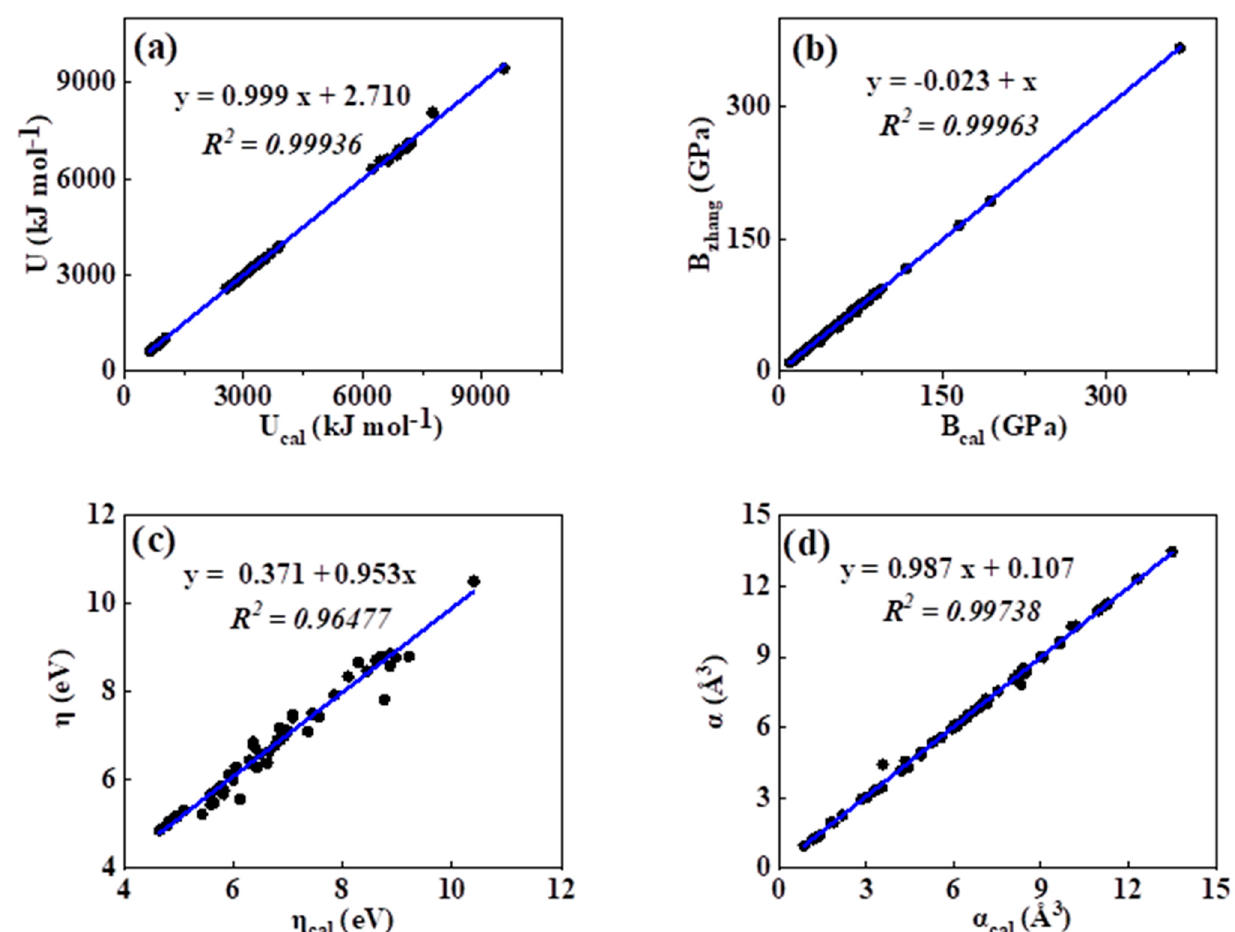
Figure 5. Plot of correlation between the present calculated values and the date reported in the literature. ( a ) lattice energy, ( b ) bulk modulus, ( c ) chemical hardness, ( d ) electronic polarizability).